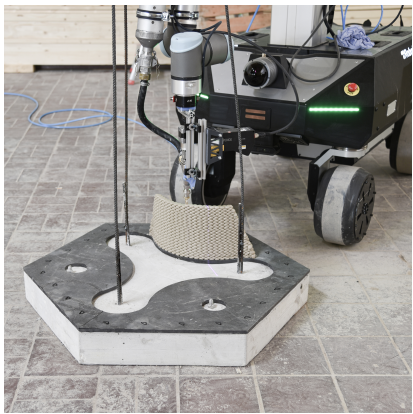
Figure 7. First printed